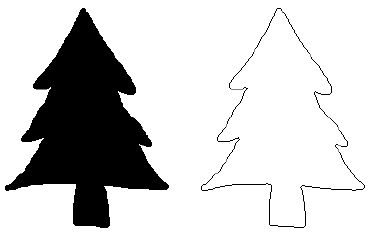
Figure 1. Object and its contour.